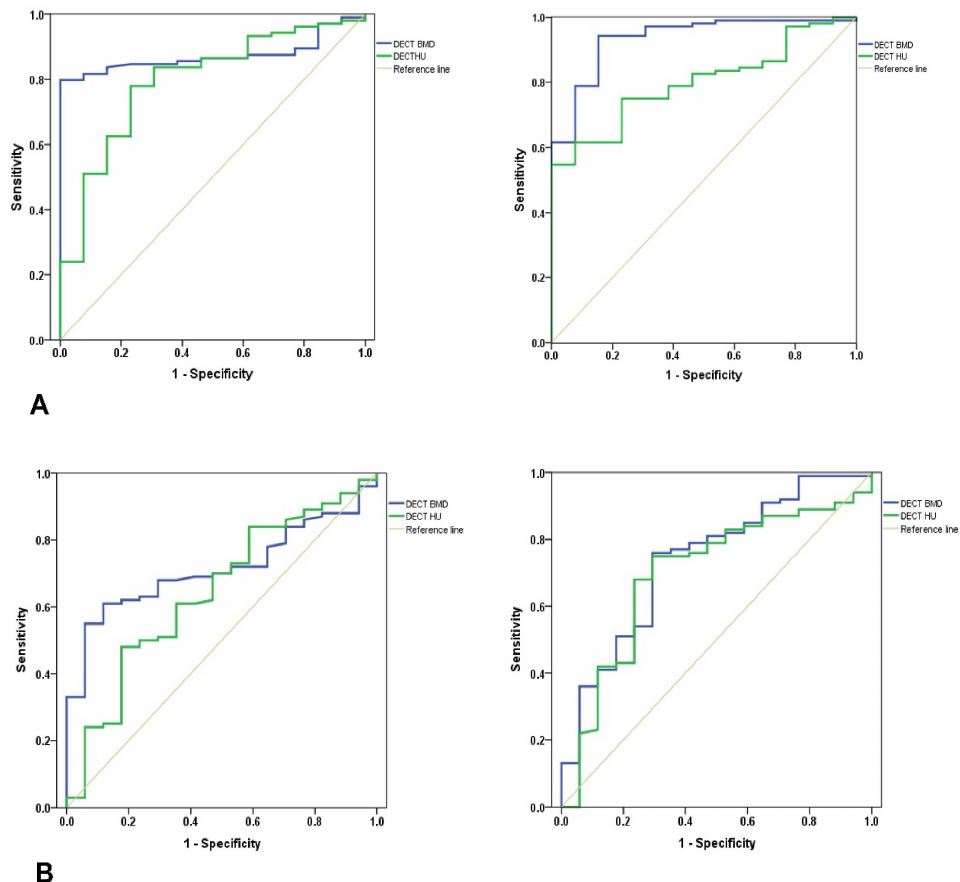
Figure 4. ( A ) Representative receiver operating characteristic (ROC) curves of phantomless volumet- ric bone mineral density (BMD) (blue line) values and Hounsfield unit (HU) measurements (green line) derived from dual-energy computed tomography (DECT) for the detection of osteoporosis using the dual x-ray absorptiometry (DXA) derived T-score of the lumbar spine as the reference standard. (Left: values in distal femur; Right: values in proximal tibia); ( B ) Representative receiver operating characteristic (ROC) curves of phantomless volumetric bone mineral density (BMD) (blue line) values and Hounsfield unit (HU) measurements (green line) derived from dual-energy computed tomogra- phy (DECT) for the detection of osteoporosis using the dual x-ray absorptiometry (DXA) derived T-score of the femur neck as the reference standard. (Left: values in distal femur; Right: values in proximal